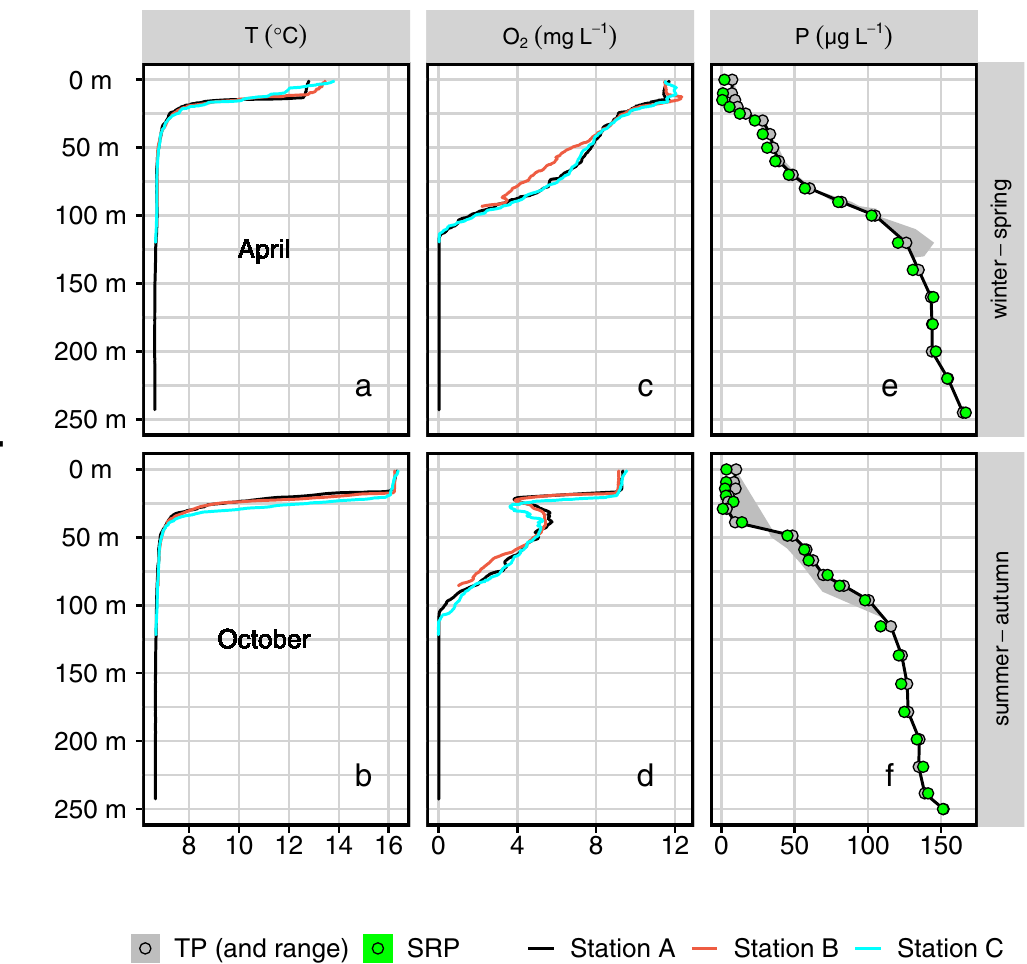
Figure 2. Selected physicochemical properties of Lake Iseo’s water column. Water column profiles of temperature (T, panels a / b ), and dissolved oxygen (O 2 , panels c / d ) were obtained from the three measurement stations A-C (colors). The symbols in panels ( e / f ) show concentration of total (TP, grey) and soluble reactive phosphorus (SRP, green) in the water column at Station A. The grey shaded areas show the range of TP across the three measured stations. Upper and lower row of all panels show profiles taken in April and October of 2017,